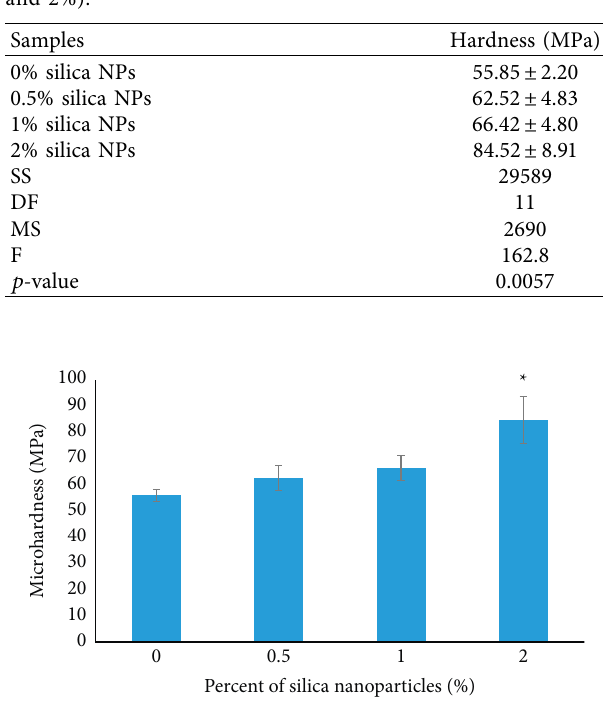
Figure 5: Results of hardness test. An asterisk represents a sta- tistically significant difference ( p < 0.05) between the groups (0.5%, 1%, and 2%) and 0%